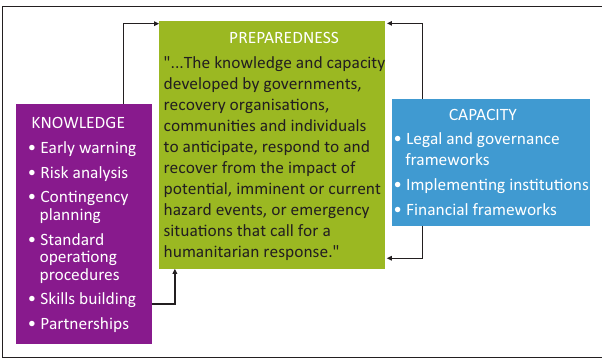
FIGURE 1: The construct of disaster